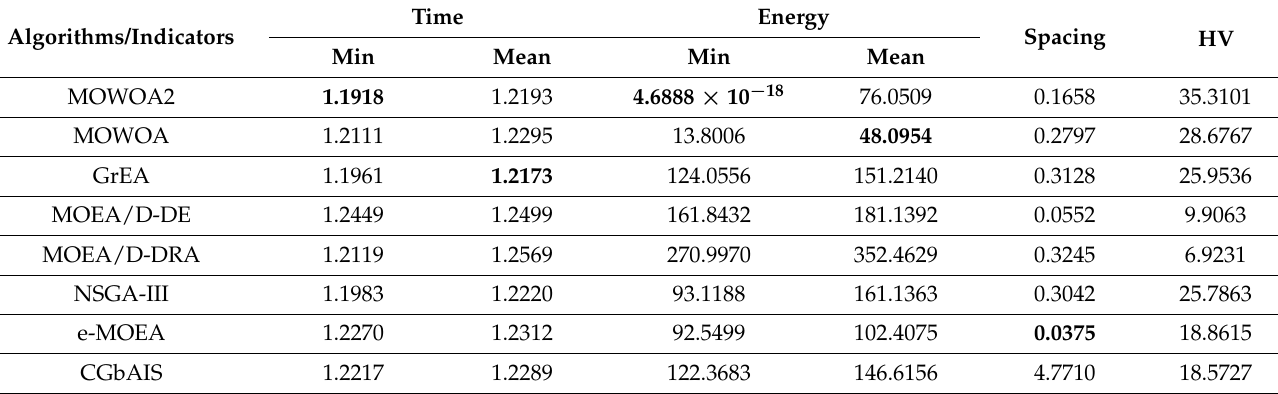
Table 3. The values of indicators using different algorithms when the user number is 30. The bold number is the best value in this column.